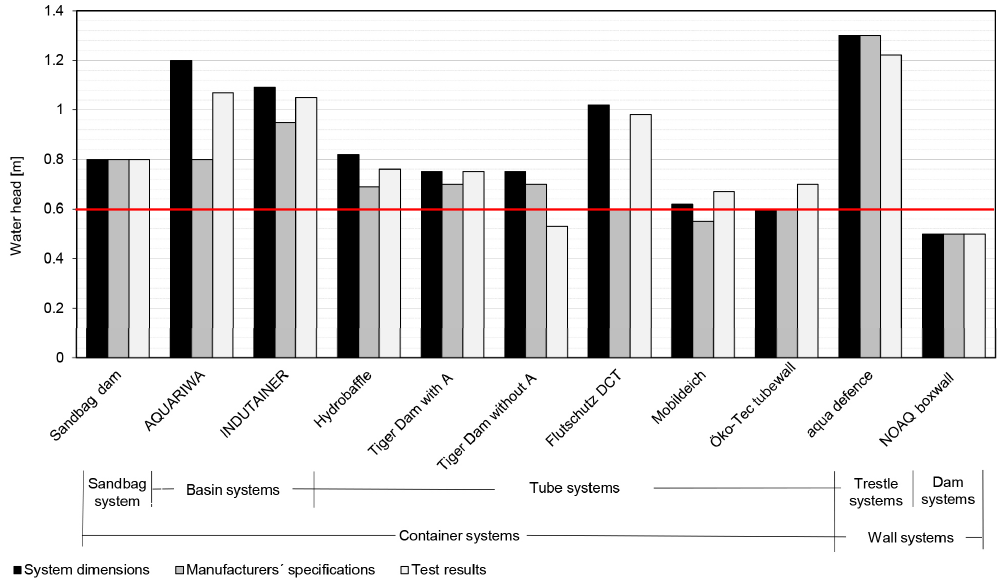
Figure 11. Water levels achieved during the test set-ups (Massolle et al., 2018). The red line marks the maximum water height of 0.6m, which is recommended for the unscheduled use of SBRSs (BWK,